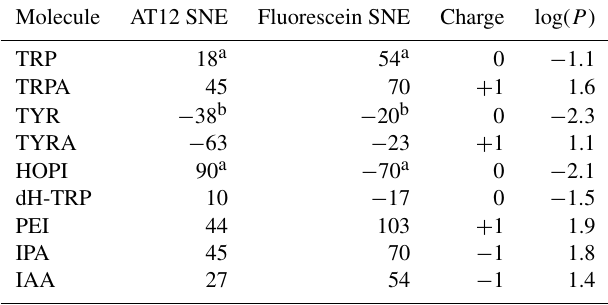
Table 1. Signal enhancement of tryptophan and tyrosine derivatives (100µM) after irradiation in the presence of AT12 or fluorescein (20µM) at 1W for 4s. The reported charges are of the diamagnetic molecules. The values for the tyrosine enhancement are taken from Sobol et al. (2019) and for the tryptophan and HOPI enhancement from Torres et al. (2021). Nevertheless, sample conditions were identical. The log( P ) is the logarithm of the partition coefficient P , and P is the ratio of the concentration of the compounds in a mixture of the